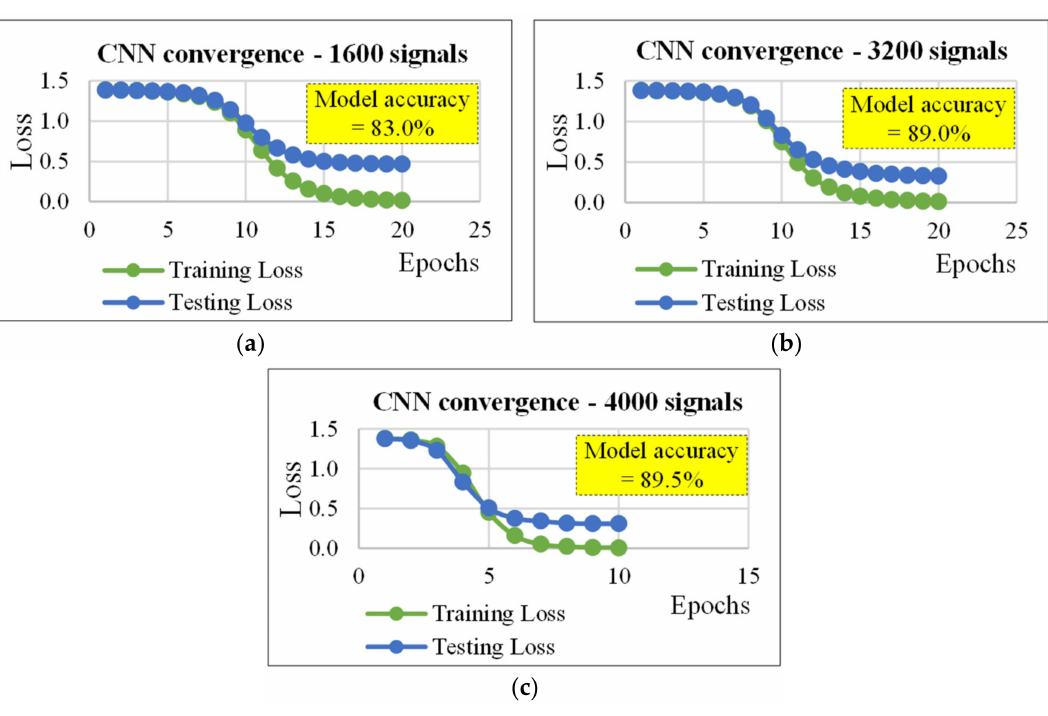
Figure 5. Convergence plots for the CNN (cf. Table 2): ( a ) data set size (D) = 1600 signals; ( b ) D = 3200 signals, and (c) D = 4000